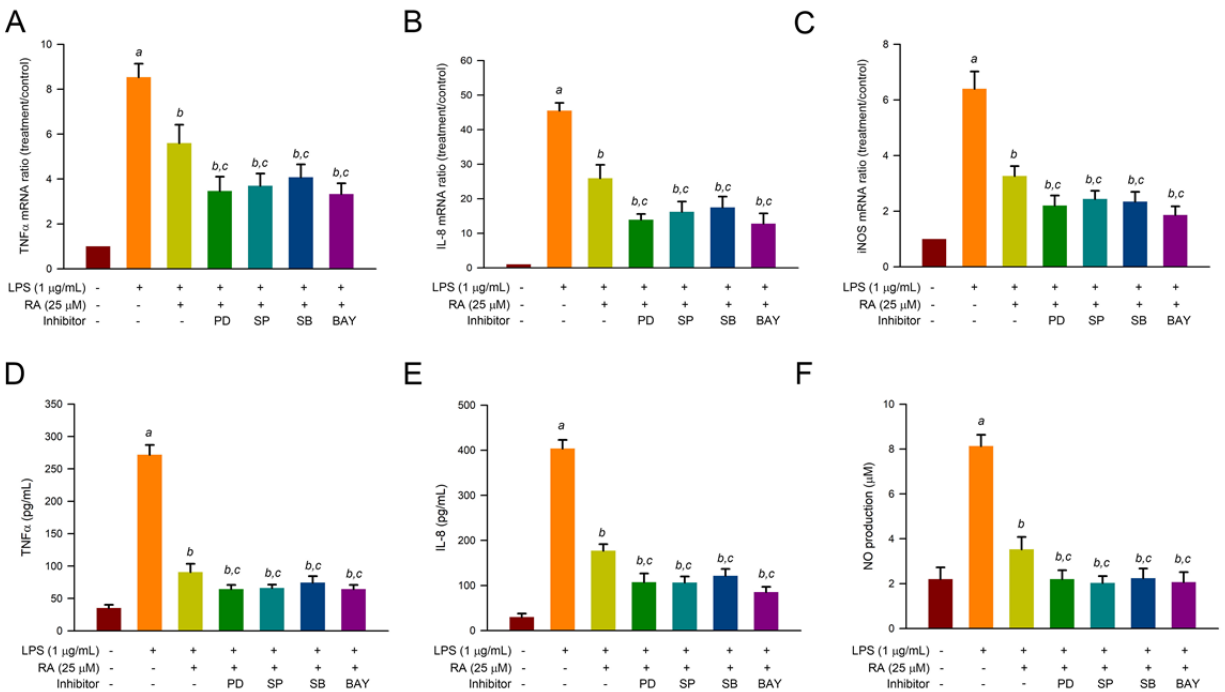
Figure 4. Involvement of MAPK activation and NF- κ B signaling in RA-downregulated mRNA ex- pression and production of pro-inflammatory mediators by A7r5 cells with LPS stimuli. Cells were pretreated with RA at 25 μ M or RA combined with PD98059 (PD), SP600125, or SB203580 (SB) for 2 h, then treated with LPS for 6 h or 24 h. The 6 h LPS-treated cells were subjected to ( A – C ) mRNA